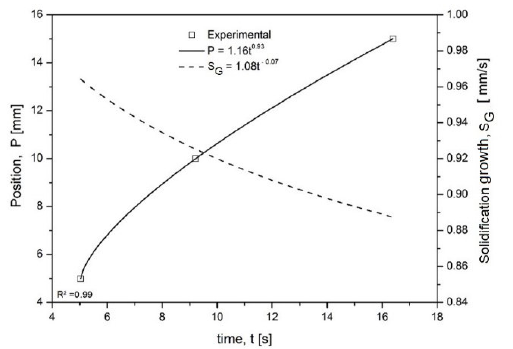
Figure 4. Position of liquidus temperature ( P ) and solidification growth ( S ) versus time. G